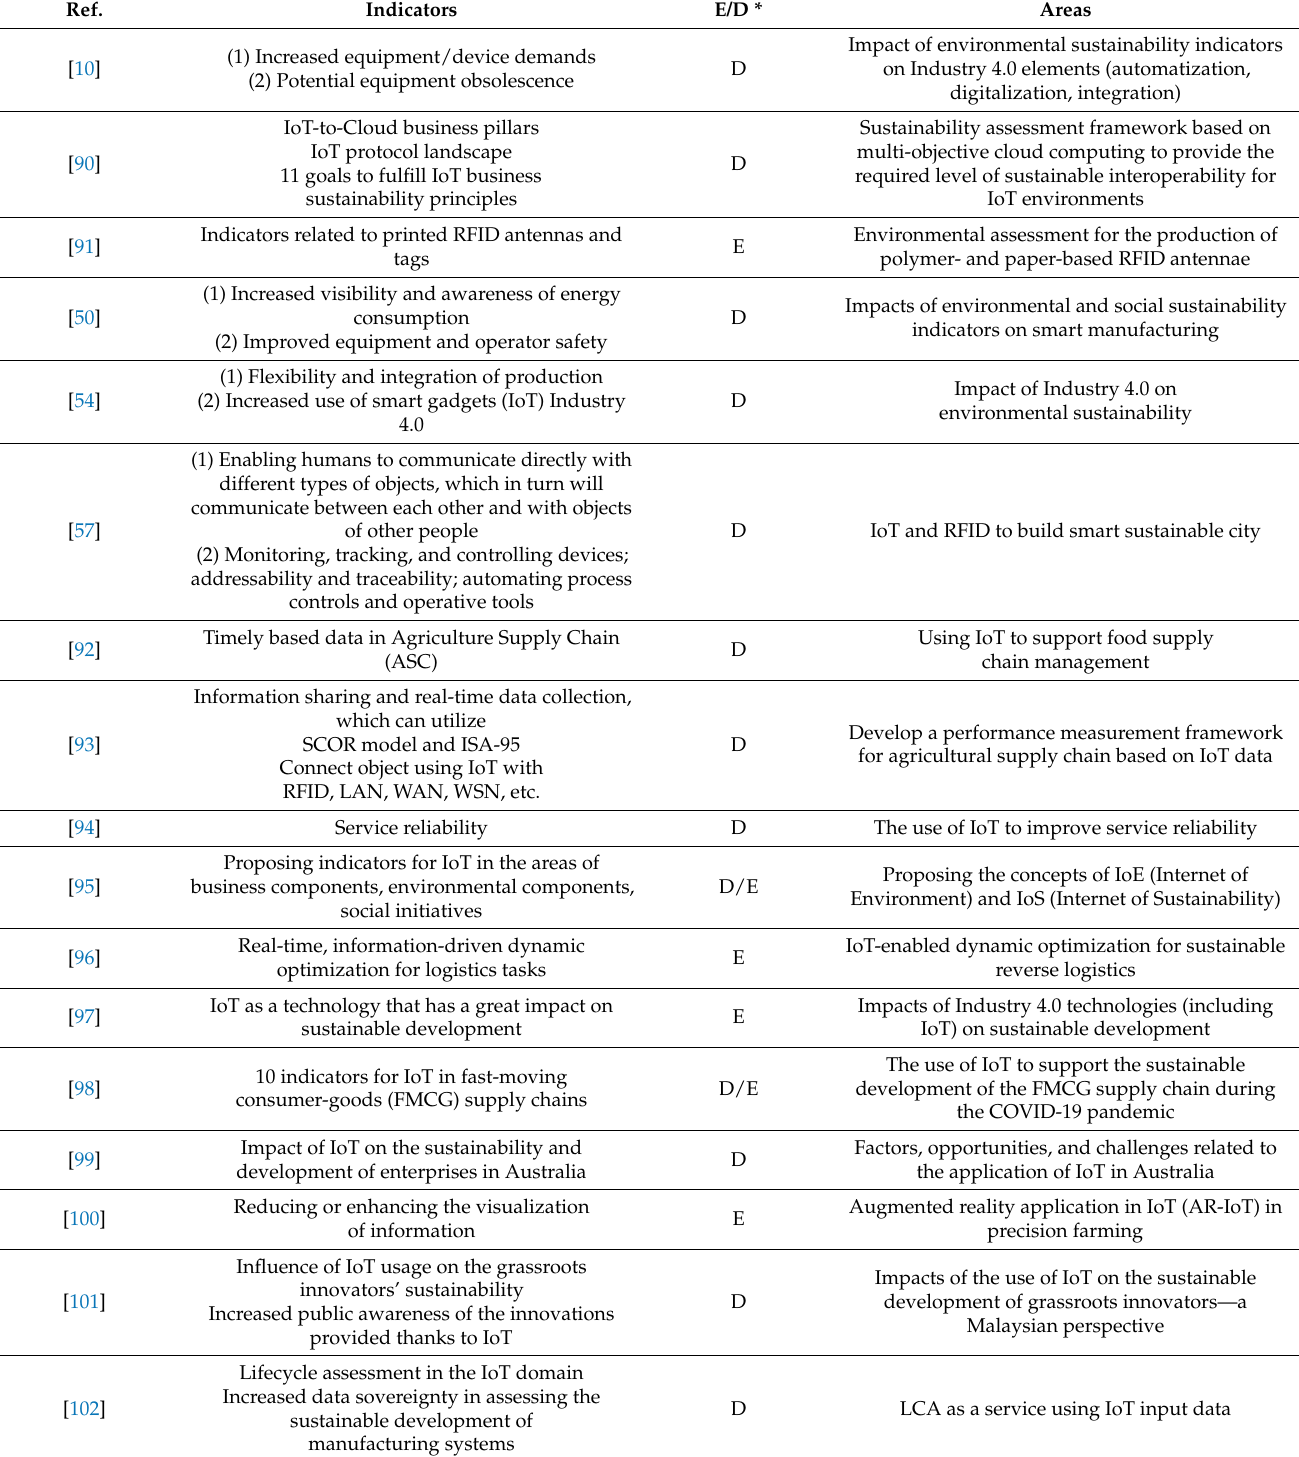
Table 2. Calculation indicators in recent IoT